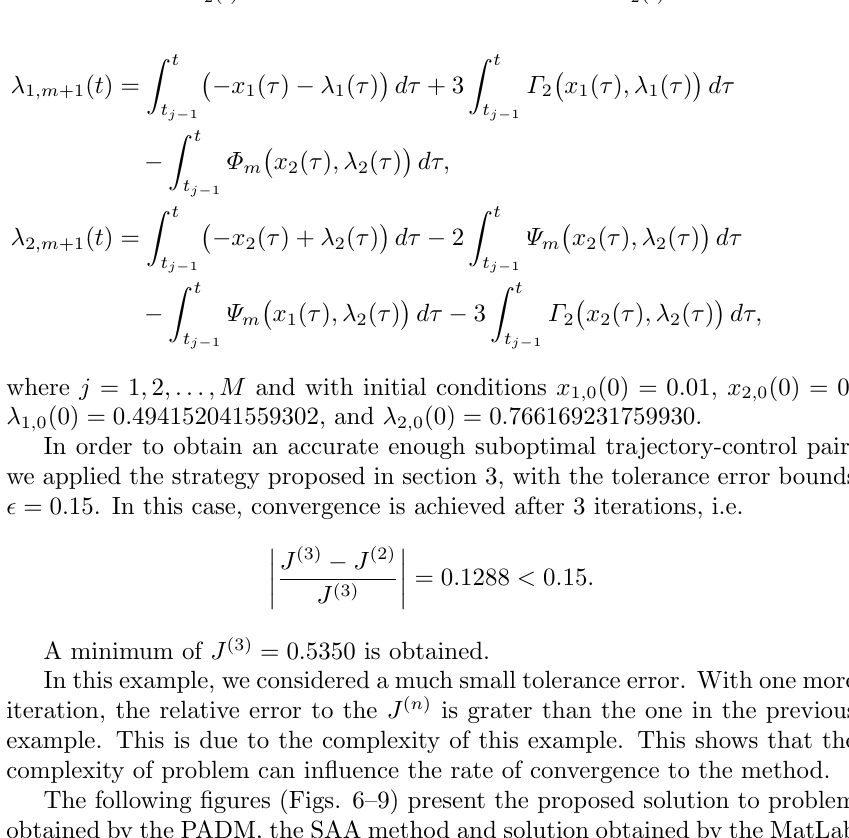
Figure 9. The optimal control function u 2 ( t